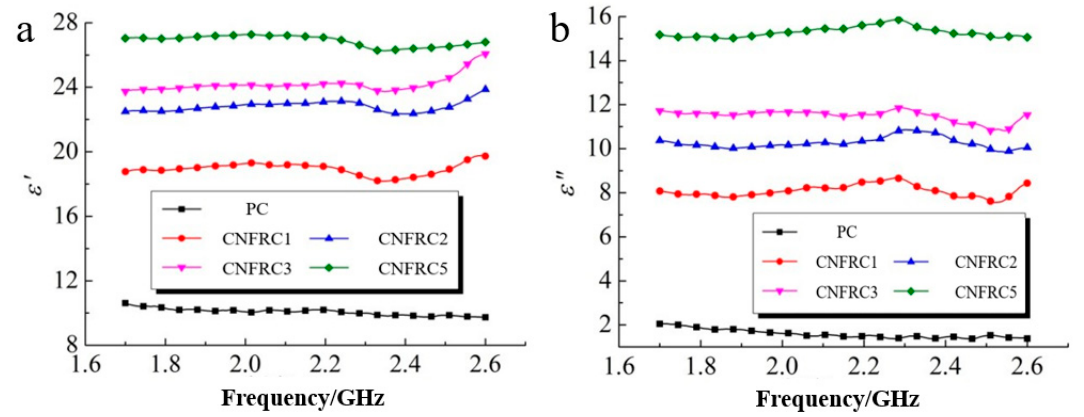
Figure 4. Dielectric constant of carbon nanofiber reinforced concrete ( a ) ε , ( b ) ε , .